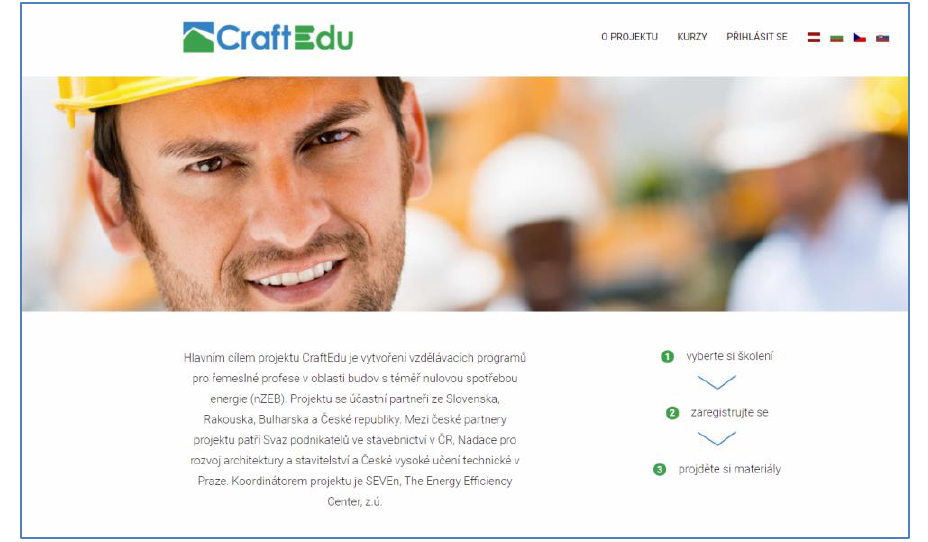
Figure 1: Login/Introduction screen – for the Czech variant (source: